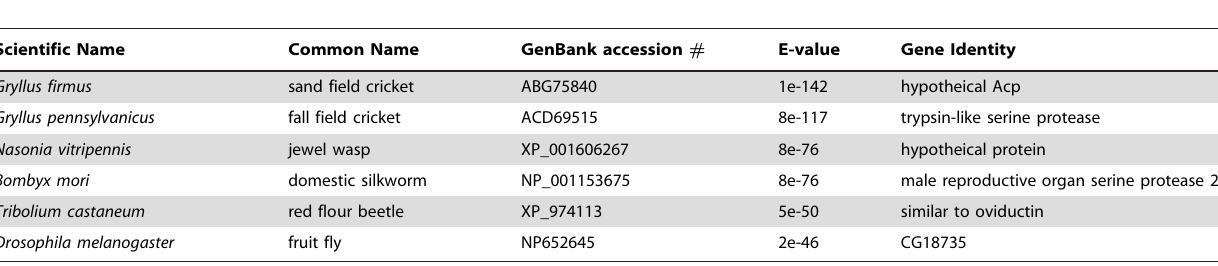
Table 2. BLASTP analysis of the full length transcript underlying protein